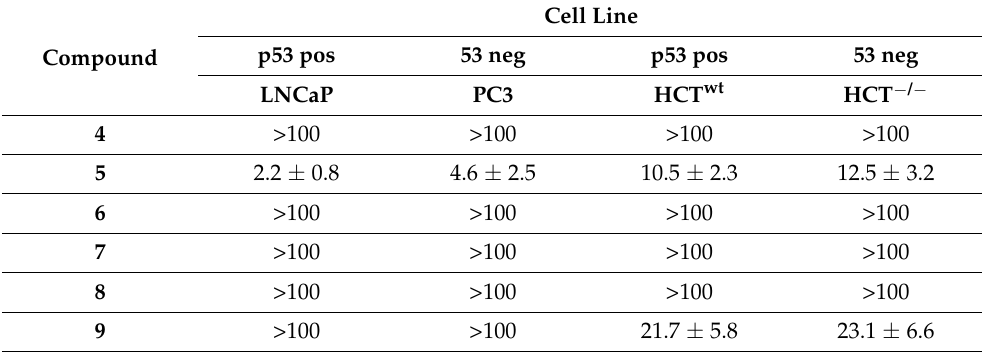
Table 2. Cytotoxicity (IC 50 , µ M) of compounds 4 – 69 . The data for the most cytotoxic compounds are highlighted in background